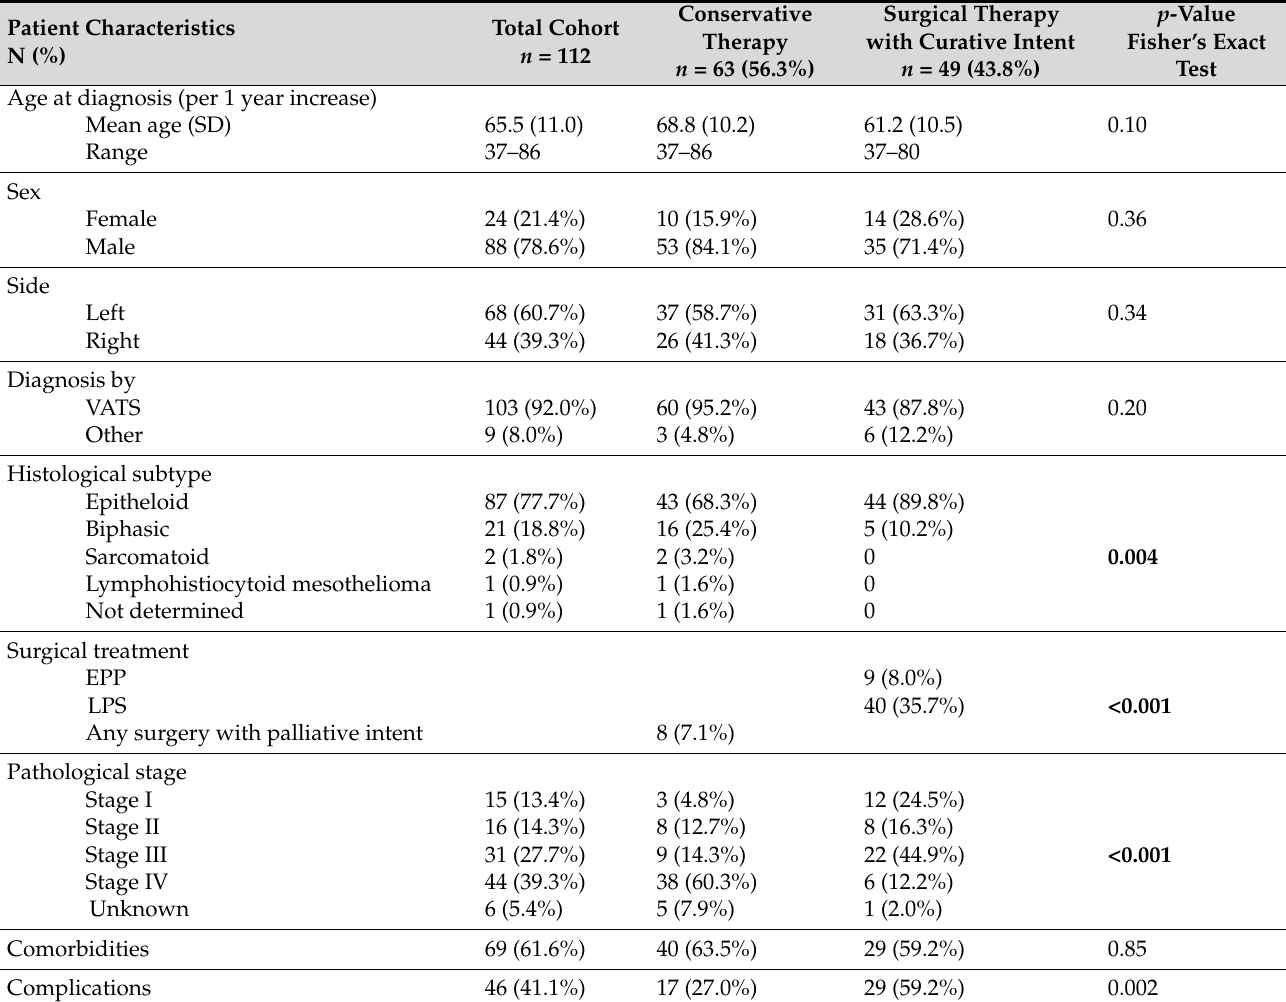
Table 1. Patients’ characteristics. The subgroups of patients were tested for independence; the p -value was determined by Fisher’s exact test. EPD extended pleurectomy/decortication, EPP extrapleural pneumonectomy, LPS lung-preserving surgery, VATS video-assisted thoracoscopic surgery, SD standard deviation, statistically significant p -values were printed in